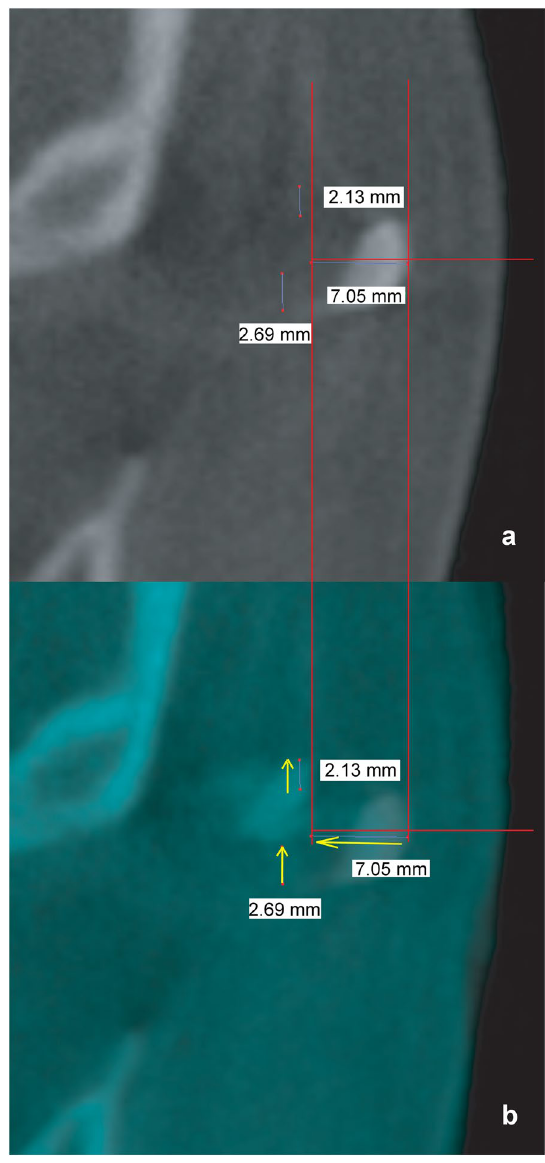
Fig. 4 Measurements of the vertical and inward movement of the zygomatic arch on each side in the coronal plane. The investigator averaged the vertical changes at the upper and lower edges. A positive value indicates that the postoperative height of the zygomatic bone exceeded the preoperative height. Values are presented in yellow. The yellow arrow indicates the direction of postoperative zygomatic arch